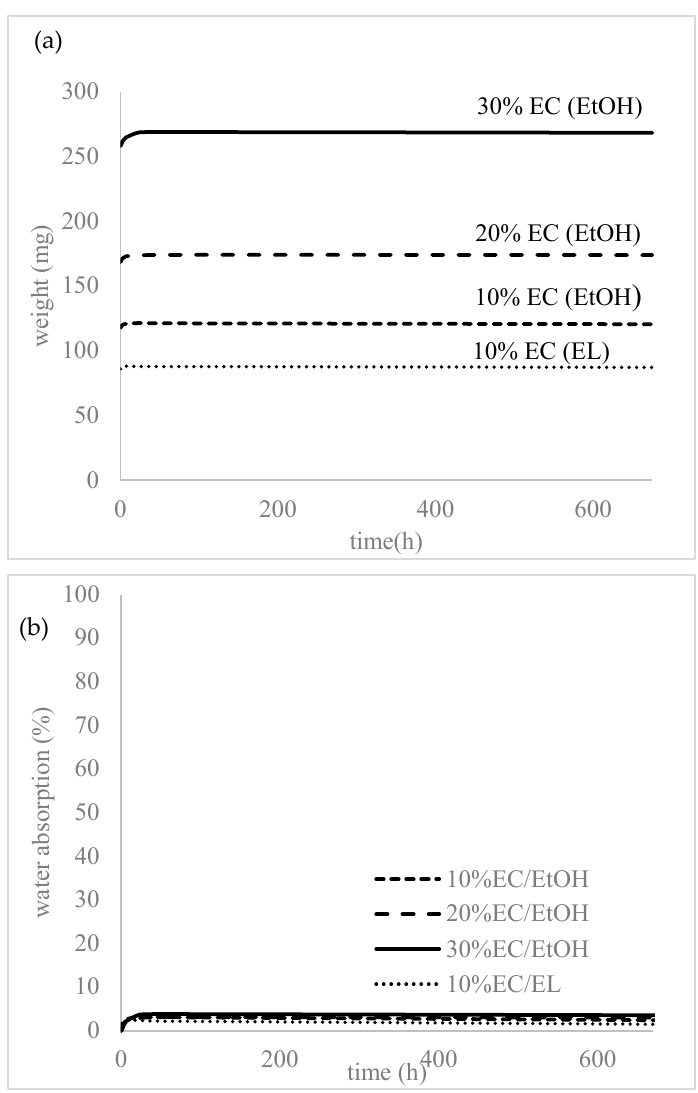
Figure 3. FE-SEM micrographs of the EC films. ( a ) Surface of film. ( b ) Cross-section of film. ( c ) TiO 2 deposition inside EC film. ( d ) EDS analysis of the 10% EC(EtOH)TiO 2 film.